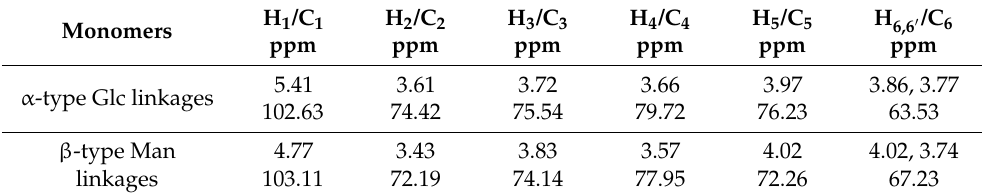
Table 1. Chemical shifts of C 1 ~C 6 and H 1 ~H 6 in monomers of DOPs.